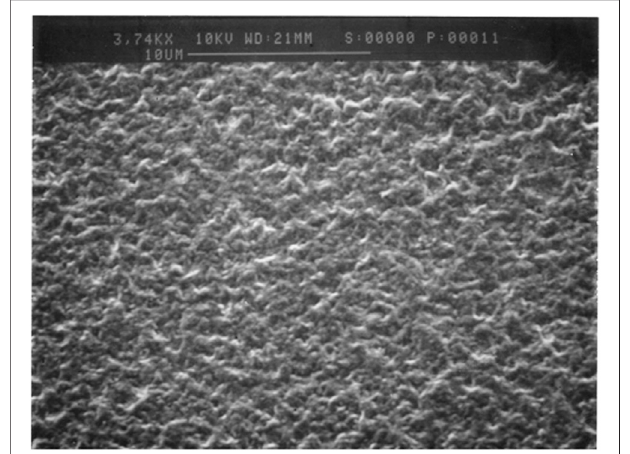
FIGURE 3 | SEM picture of poly-3,3 ″ -DDTT in the neutral state. Similar to the treatment of the electrodeposit described in (Naoi et al., 1991), the polymer was rinsed with CHCl 3 and successively dried with a stream of N 2